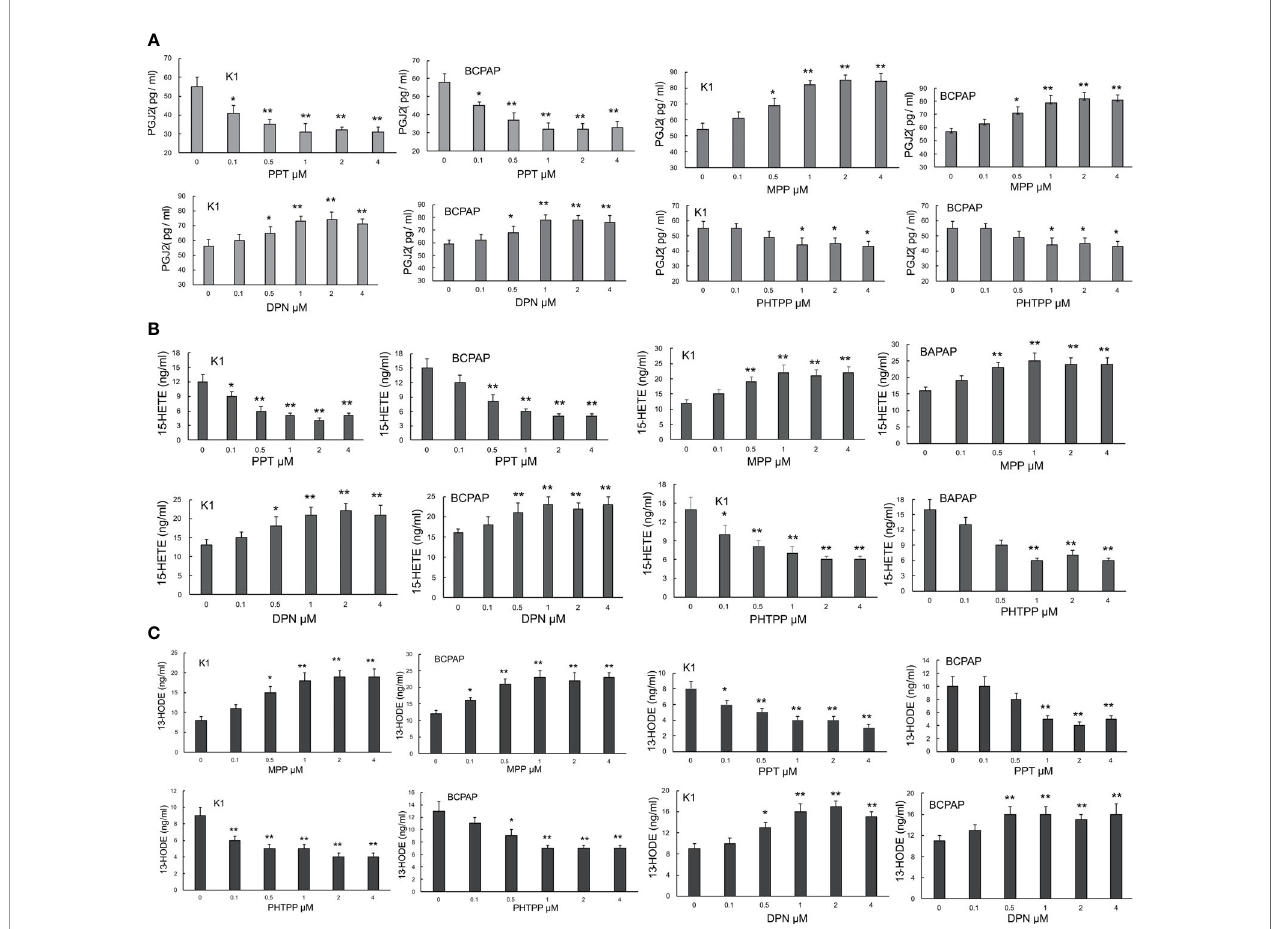
FIGURE 2 | The impact of ER modulation on the levels of PGJ2, 15(S)-HETE and 13(S)-HODE in PTC cells. K1 and BCPAP cells were respectively treated with PPT, MPP, DPN and PHTPP at the given concentrations (0, 0.1, 0.5, 1, 2, 4µM for all 4 modulators) for 48 hours. At the end of the treatment, the levels of PGJ2 (A) , 15(S)-HETE (B) and 13(S)-HODE (C) in cells were measured by ELISA kits (Cayman Chemical (Ann Arbor, MI, and Enzo Life Sciences, Farmingdale, NY). The ELISA was performed according to the instructions of the manufacturers. *p < 0.05, **p < 0.01, compared with the control (0